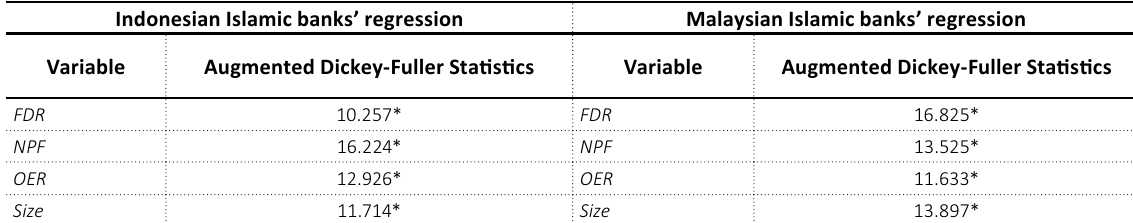
Table 10. Test results of the augmented Dickey-Fuller test (first difference)